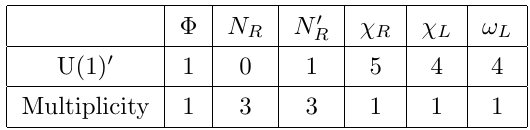
Table 1 . Charge assignment and multiplicity of the new (cid:12)elds considered in this model. limit where this parameter goes to 0, a small chosen value of (cid:22) all scales [71]. Notice that a term L (cid:27) (cid:8) (cid:31) rede(cid:12)ne the (cid:12)elds to a basis where this term is absent. In the following we will analyse the implications of the individual parts of the Lagrangian